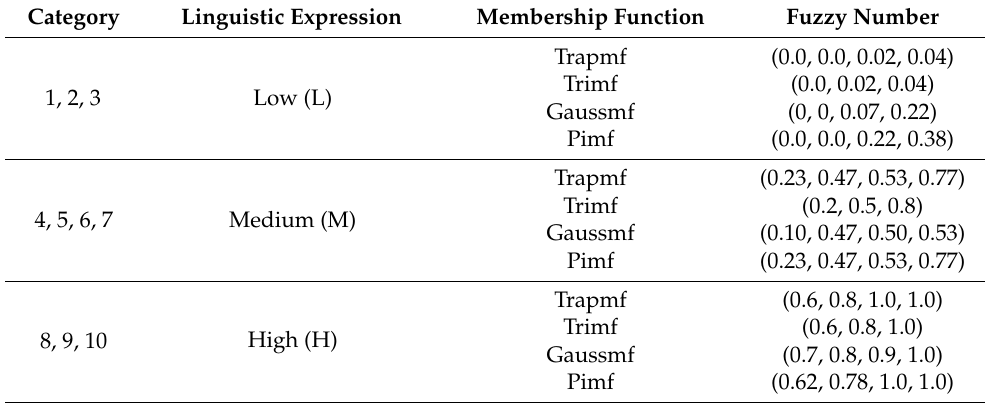
Table 3. 3-scale fuzzy number with 4 membership functions.